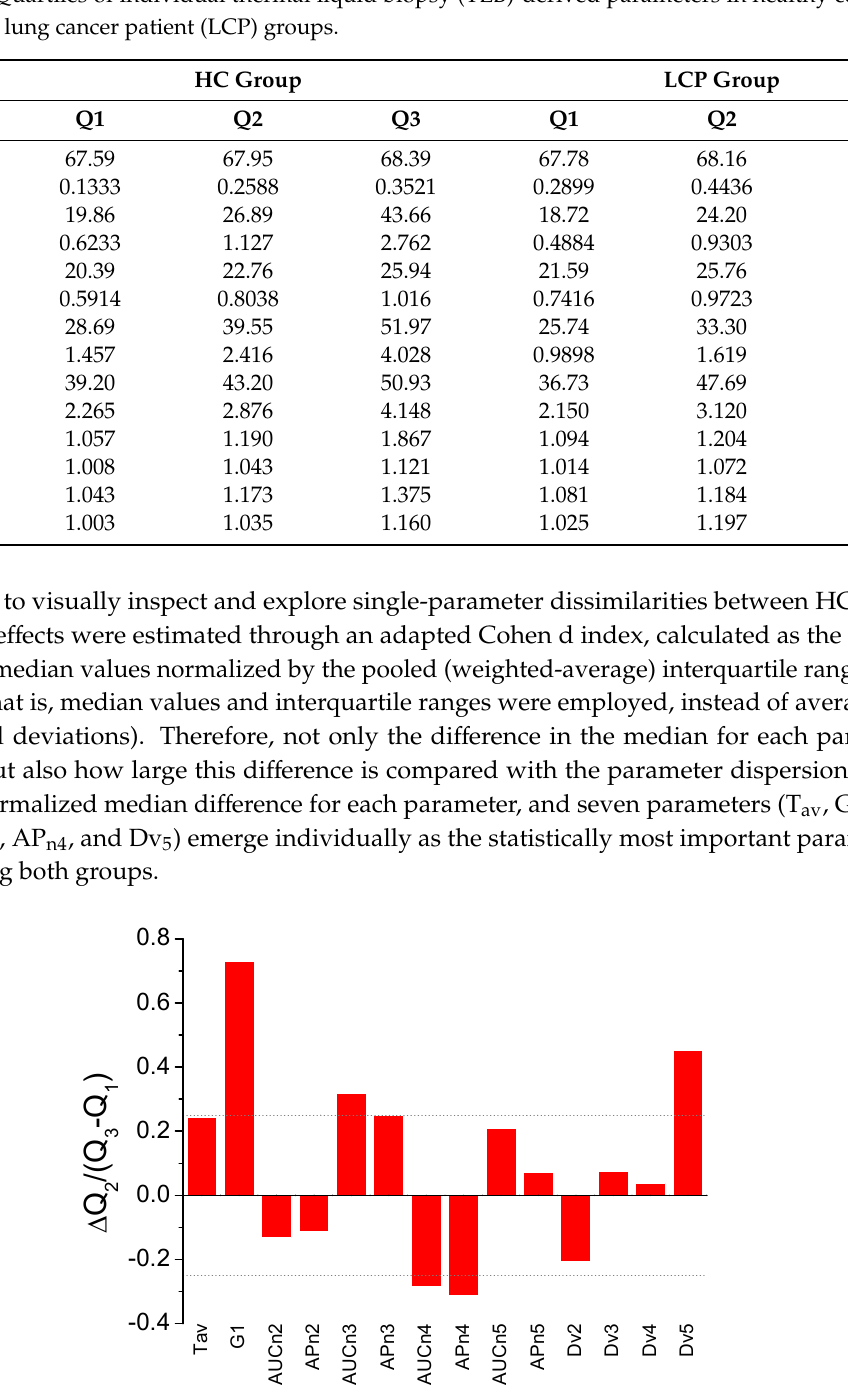
Figure 2. Adapted Cohen d index as a measure of size effect between healthy control (HC) and lung cancer patient (LCP) groups (difference between the median values normalized by the pooled interquartile range) for the individual parameters derived from TLB serum thermograms. Some of the parameters show large differences between the two groups: T av , G 1 , AUC n3 , AP n3 , AUC n4 , AP n4 , and Dv 5 (a threshold value of ± 0.25 is indicated by the dotted line).